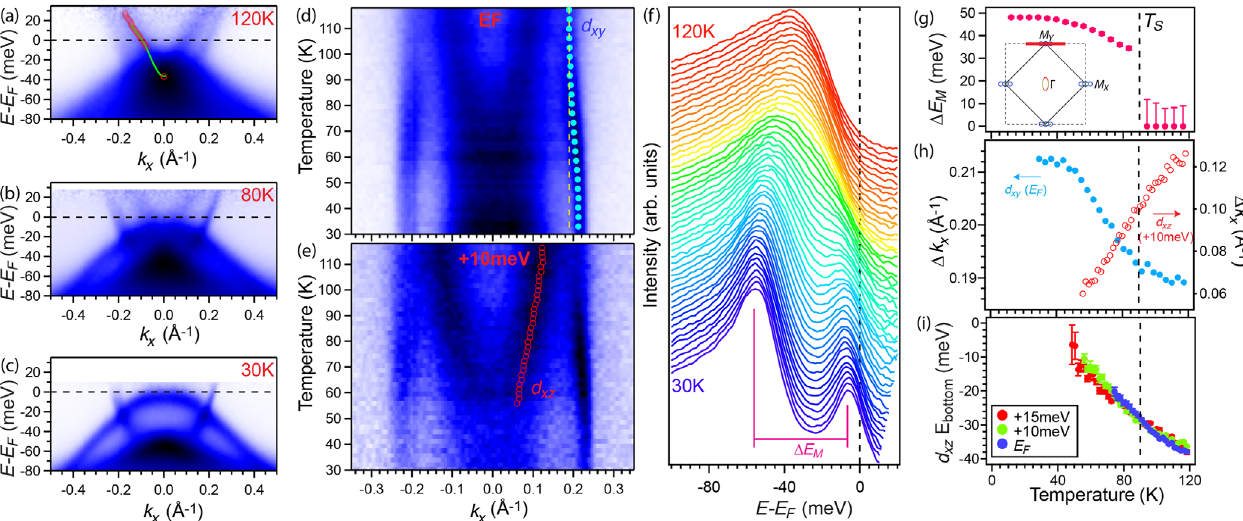
FIG. 4. Temperature evolution of the electron bands orthogonal to Γ − M Y . (a) – (c) Raw spectra taken at selected temperatures across M Γ − M Y on a detwinned FeSe. The cut direction is shown in the inset in (g), perpendicular to the Y high symmetry. Polarization is even with respect to the cut. All cuts are divided by the Fermi-Dirac function convolved with the instrumental resolution. Fitted MDC peaks of the inner electron band are shown for the left half (red circles), along with the fitted even function for the inner electron band (green). (d) Temperature evolution of the MDC taken at E F of the cut in (a). The yellow dotted line marks the outer MDC peak position at 120 K for reference. Fitted MDC peaks for the outer d xy electron band are shown. (e) Temperature evolution of the MDC taken at þ 10 meV of the cut in (a), with fitted MDC peaks for the inner d xz band shown. (f) The EDCs taken at the M Y point in (a) taken from 30 to 120 K. (g) Fitted peak separation in energy in (f) as a function of the temperature. (h) Fitted MDC peak positions for the outer d xy and the inner d d xz electron bands reproduced from (d),(e). (i) The projected energy of the inner xz electron band bottom with the temperature estimated from the shift in MDC peaks and the k -to- E conversion based on the assumption of a rigid band shift from the 120 K data in